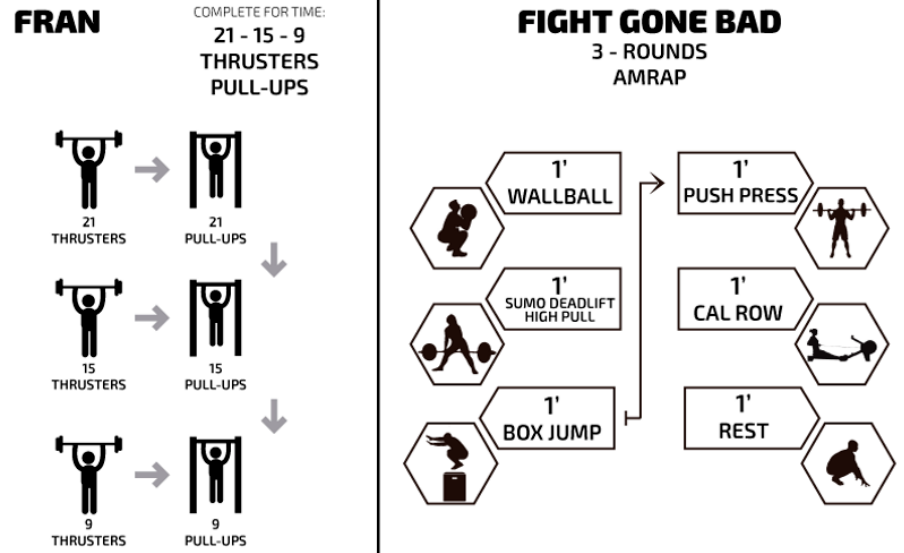
Figure 1. Description of training protocols.